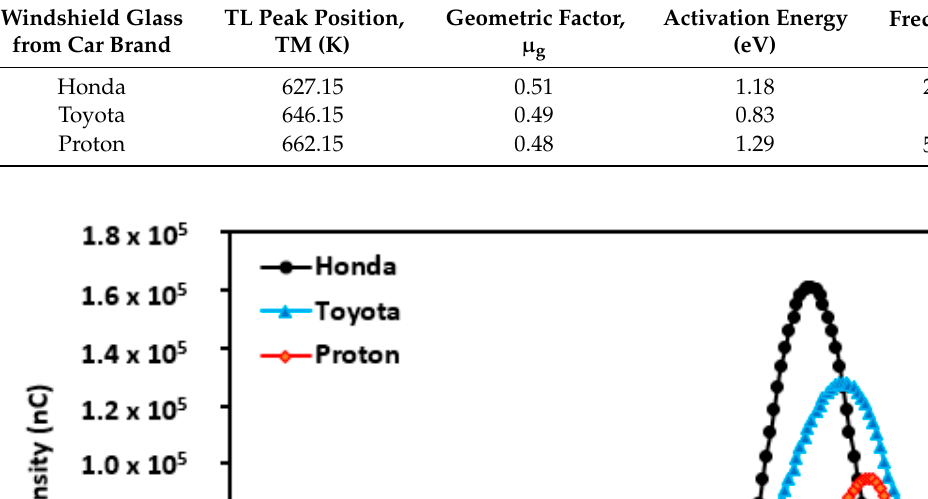
Table 3. Estimation of the trapping parameters of windshield glass for different car brands subjected to the dose of 10 Gy with corresponding maximum temperatures calculated from Chen formula.